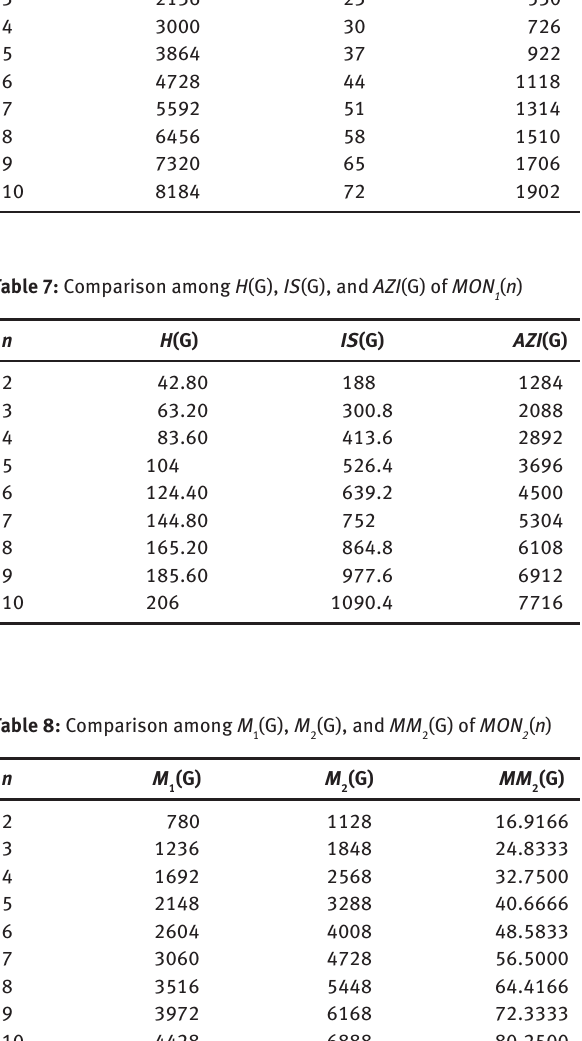
(G), RR (G), and SSD (G) of MON a a